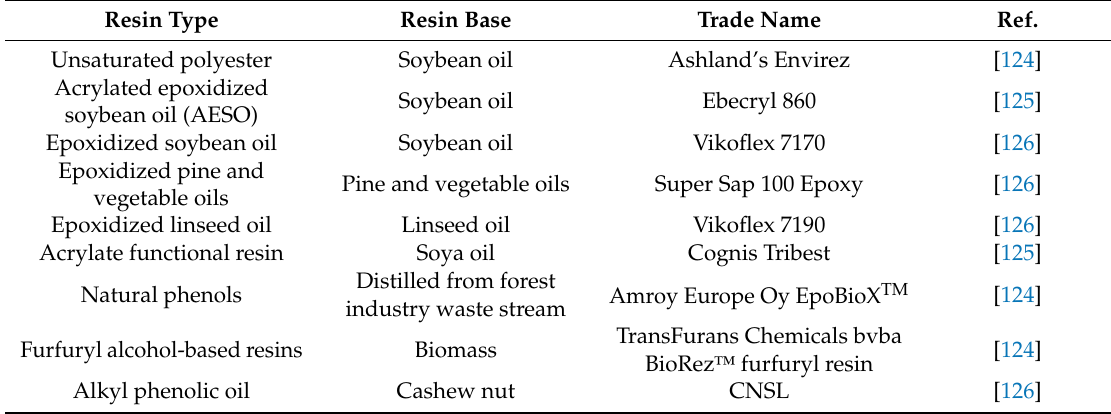
Table 5. Examples of few commercially available bio‐based thermosets .